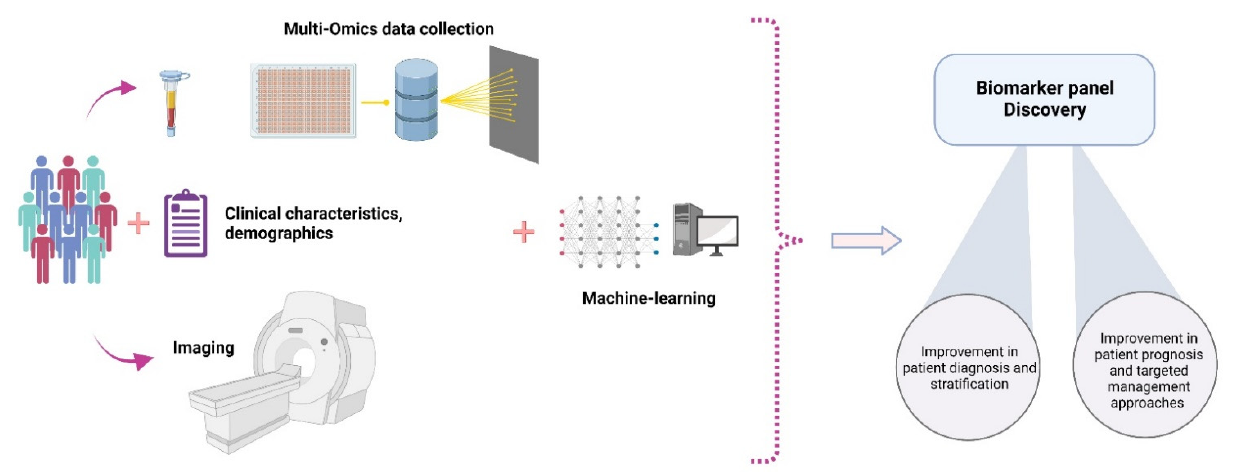
Figure 3. Future directions in the era of non-invasive diagnosis of NAFLD by integrating omics big data with clinical information and imaging (created with BioRender.com, accessed on 19 December 2021).